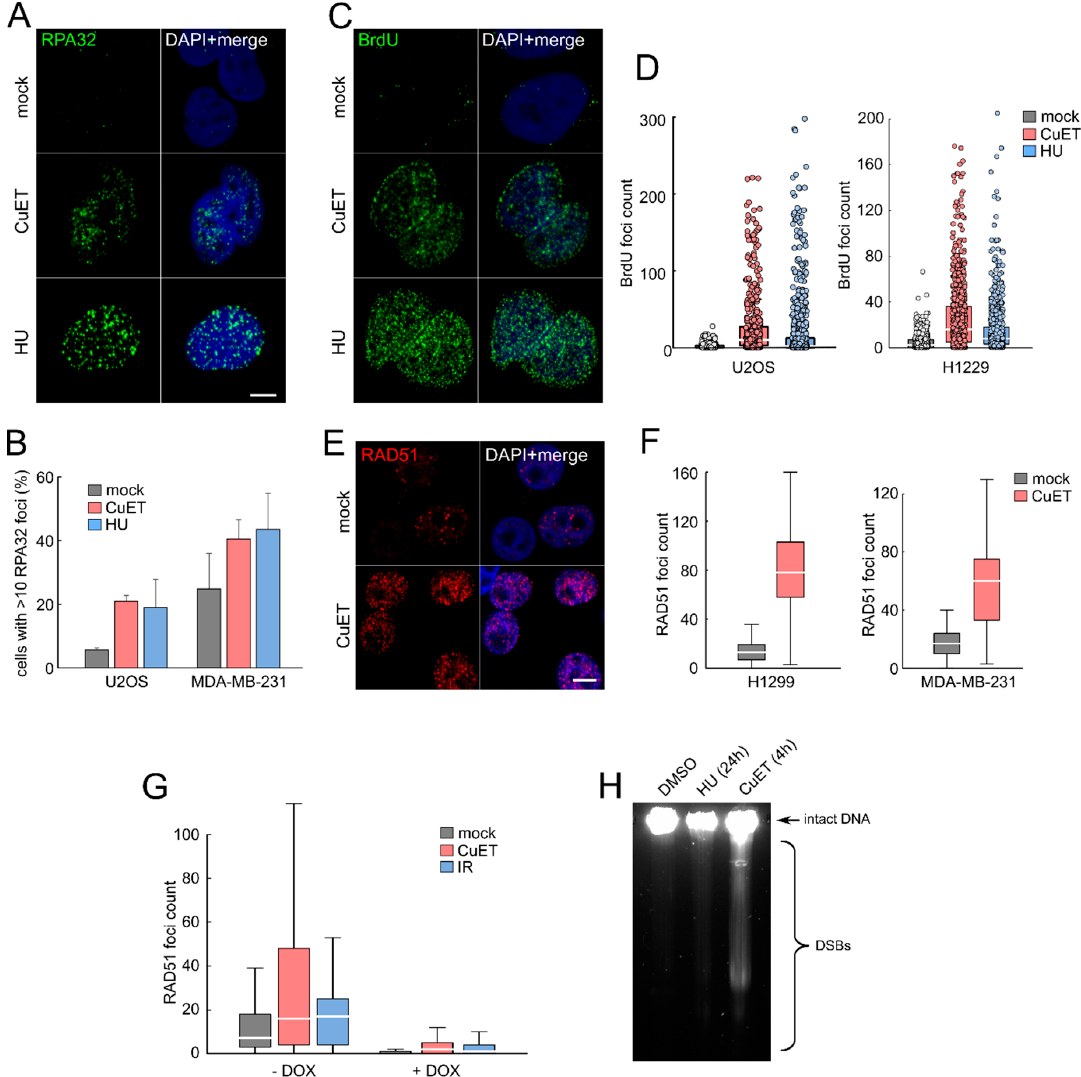
Figure 3. CuET induces replication stress. ( A ) RPA32 foci detection in pre-extracted U2OS cells treated with CuET (250 nM) or hydroxyurea (HU, 2 mM) for 5 h. ( B ) Quantification of cells with more than 10 RPA32 foci treated as in (A) (mean, SD from three independent experiments). ( C ) Formation of single-stranded DNA (ssDNA) visualized by BrdU detected under non-denaturating conditions in U2OS cells treated by CuET (250 nM) and HU (2 mM) for 5 h. ( D ) Quantification of bromodeoxyuridine (BrdU) foci in U2OS and H1299 cells treated as in C. ( E ) Detection of RAD51 foci in pre-extracted H1299 cells treated by CuET (250 nM) for 5 h. ( F ) Quantification of RAD51 foci in cyclin A positive H1299 and MDA-MB-231 cells treated by CuET (250 nM) for 5 h. ( G ) Quantification of Rad51 foci in BRCA2 proficient and deficient H1299 cells after 5-h treatment with 250 nM CuET or 4 Gray (Gy) irradiation. ( H ) FIGE analysis of DSBs in H1299 cells exposed to CuET or HU.Box plot represents 25–75 quartiles, median, and whiskers non-outlier range. Scale bars = 10 µ